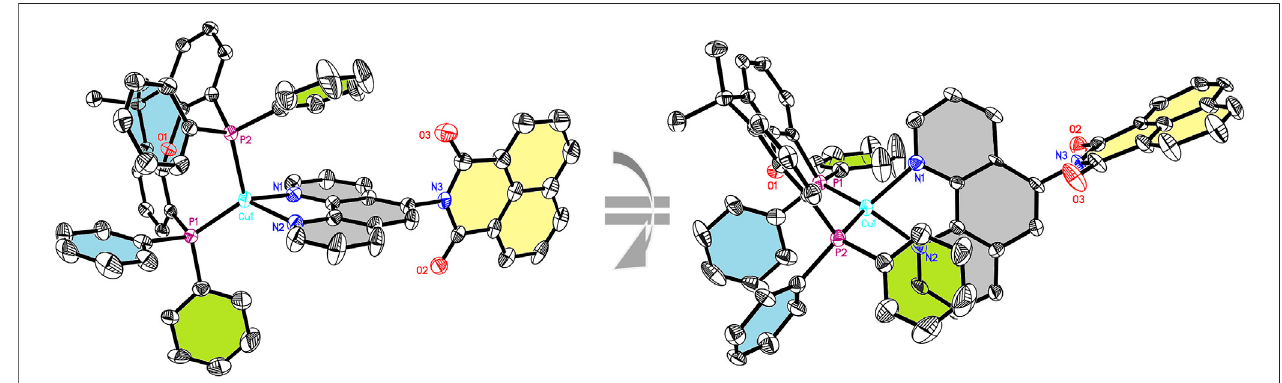
FIGURE1| Solid-statestructure(twodifferentORTEPrepresentations)of CuNIphen withthermalellipsoidsataprobabilitylevelof50%.Hydrogenatoms,counter anions, and solvent molecules are omitted for clarity. For comparison with Cuphen , Supplementary Figure S11 .